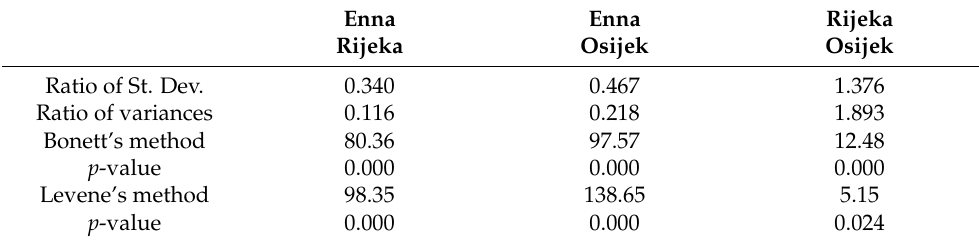
Table 10. Comparison of variances and standard deviations for pairs of analyzed